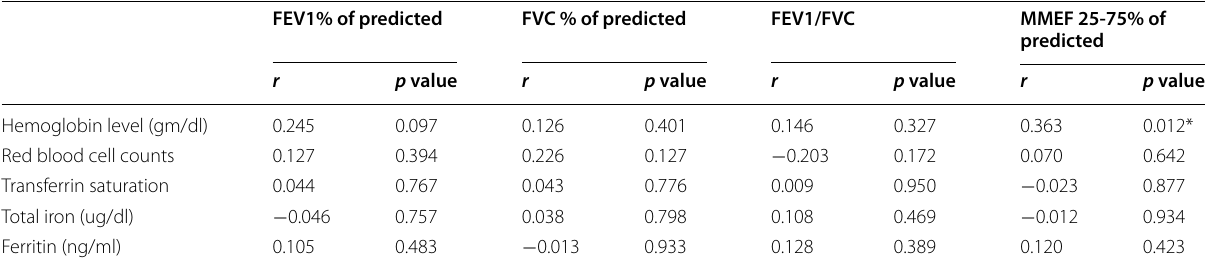
Table 6 Correlations between pulmonary function test parameters with haemoglobin level, iron profile, using Pearson correlation coefficient in asthmatic patients (with and without